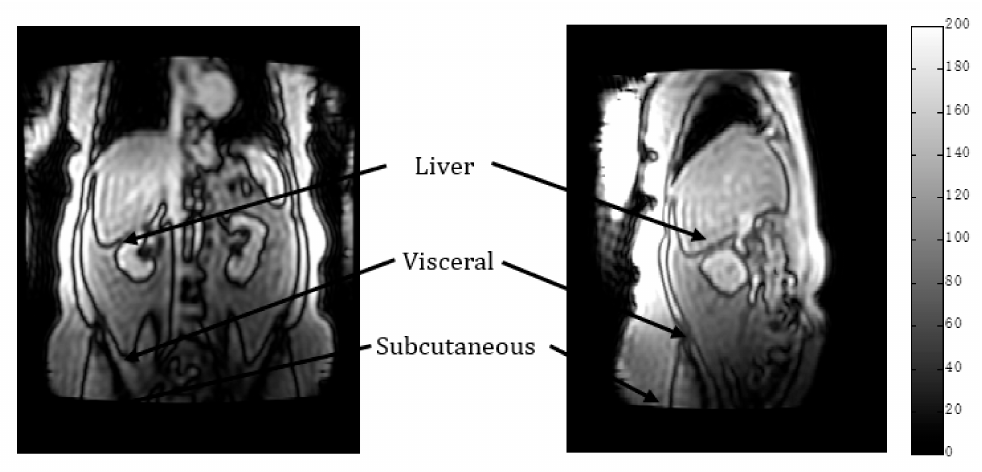
Figure 1. Coronal and oblique opposed-phase images (TE 1.3 and 1.5 ms, respectively) of a female subject with areas indicated where ROIs were drawn in the liver and two adipose tissue depots.